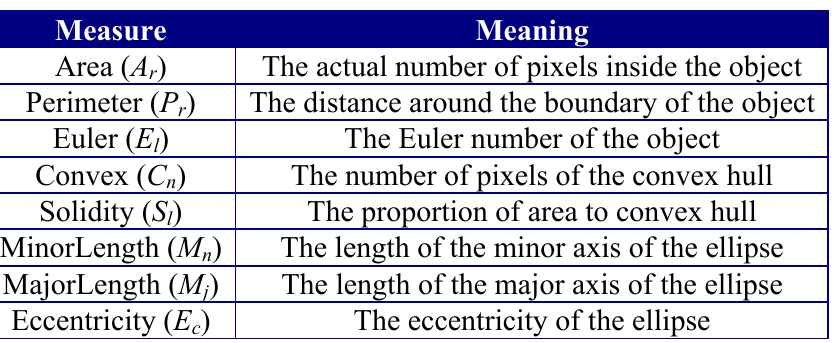
Table 2. The Morphology based